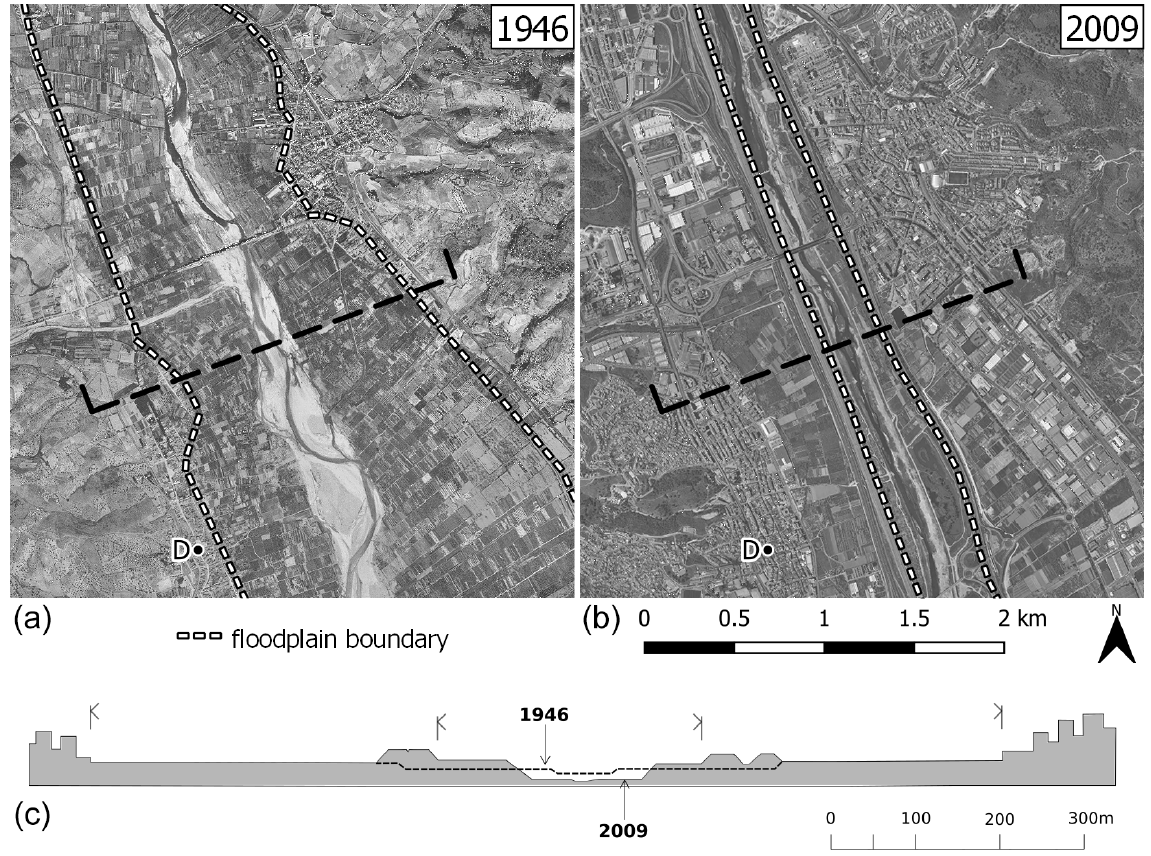
Figure 8. Plan view in 1946 (a) and 2009 (b) of the river around town D (see Fig. 4 for location) in the overlapping of reaches 2 and 3, produced by authors using freely available data from ICGC. The bridge in the middle of (a) (see Fig. 10, later) failed in 1971. (c) Cross section in reach 3 taken through the dashed line above (see Fig. 6 for more cross